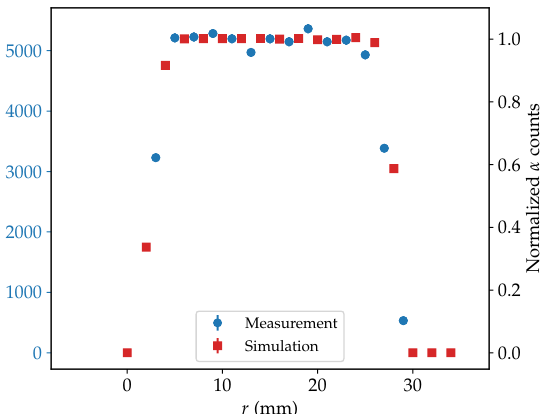
Figure 10. Dependence of the number of recorded alpha events on the radius r . Predictions from G EANT 4 simulations are also shown.